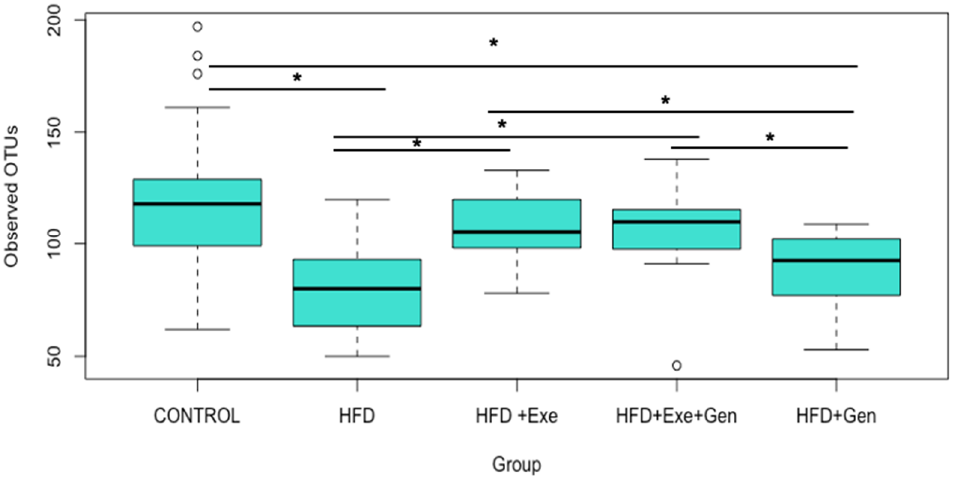
Figure 1. Microbial community richness (Observed Operational Taxonomic Units (OTUs)) comparisons in C57BL/6 mice (n = 83) after treatment with control; high-fat, high-sugar diet (HFD); HFD + Exercise (HFD + Exe); HFD + Genistein (HFD + Gen); and HFD + Exe + Gen. * denotes significant group differences according to Kruskal–Wallis ( p < 0.05) tests after Benjamini–Hochberg correction for multiple comparisons.